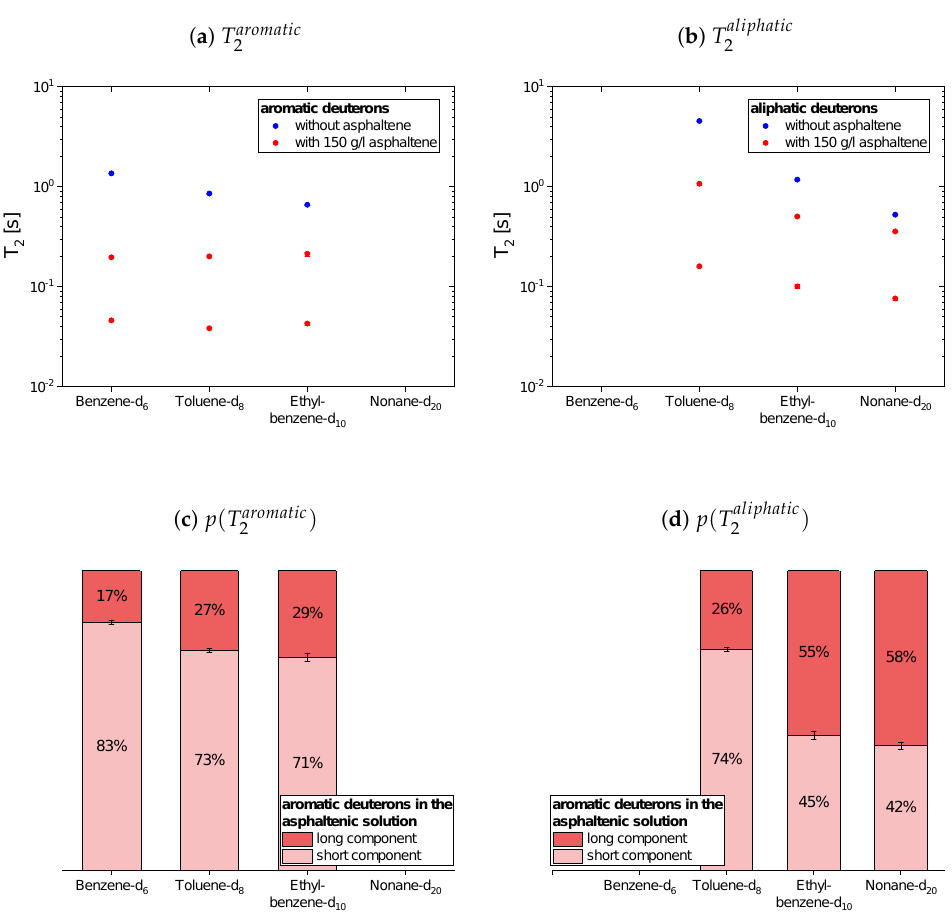
Figure 11. Top: Transverse relaxation time constants T 2 of the aromatic ( a ) and aliphatic ( b ) deuterons in the asphaltene-free and the asphaltenic solution. Bottom: Relative weight of the T 2 components of the aromatic ( c ) and aliphatic ( d ) deuterons in the asphaltenic solution. The x-axis distinguishes the different solutions, consisting of 5vol% of the specified maltene and 95vol% benzene without or with 150g/L